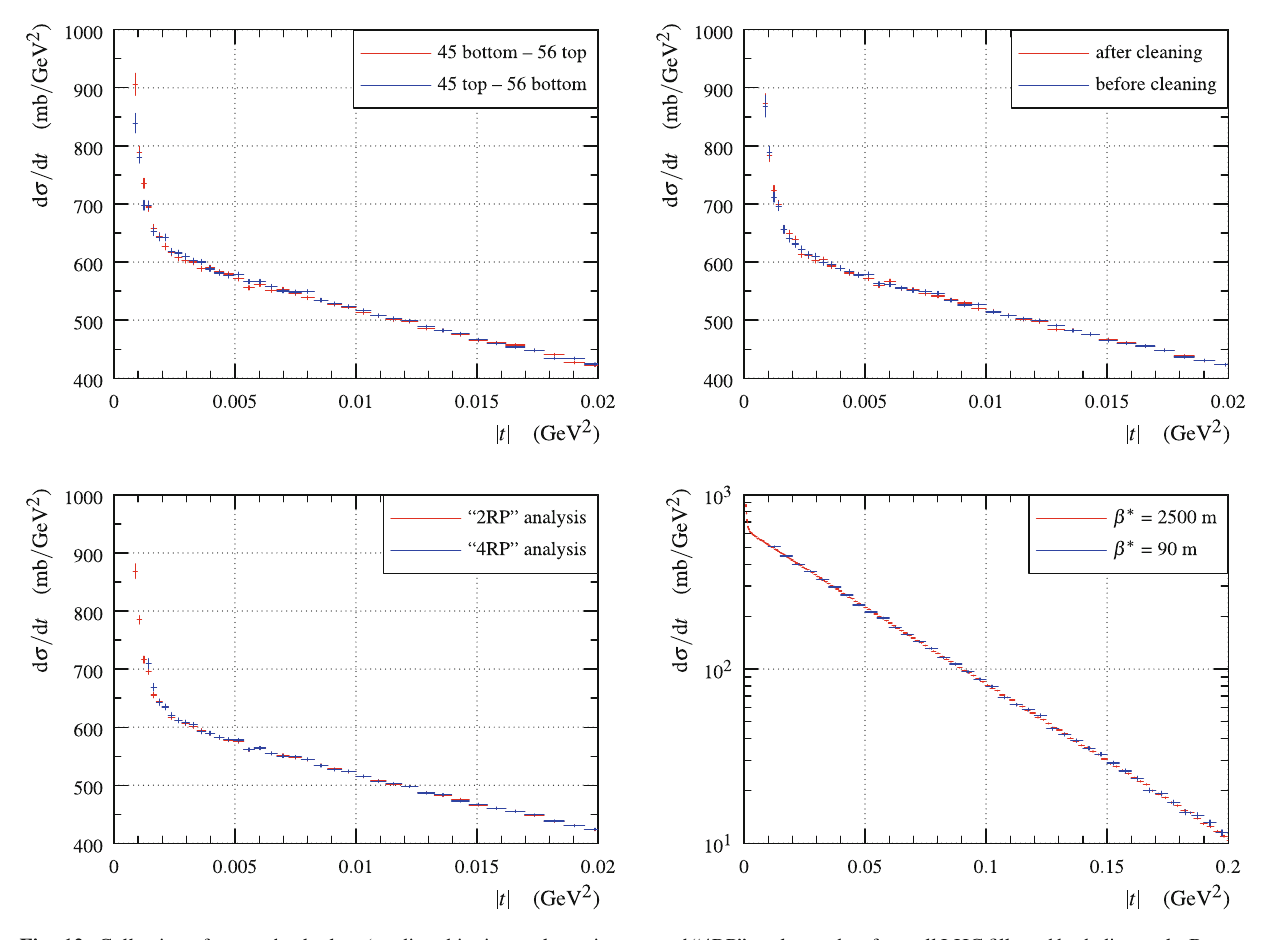
and “4RP” analyses, data from all LHC fills and both diagonals. Bottom right: comparison of results obtained from two different data-takings at the same energy but with different optics. The blue histogram is taken from Ref.